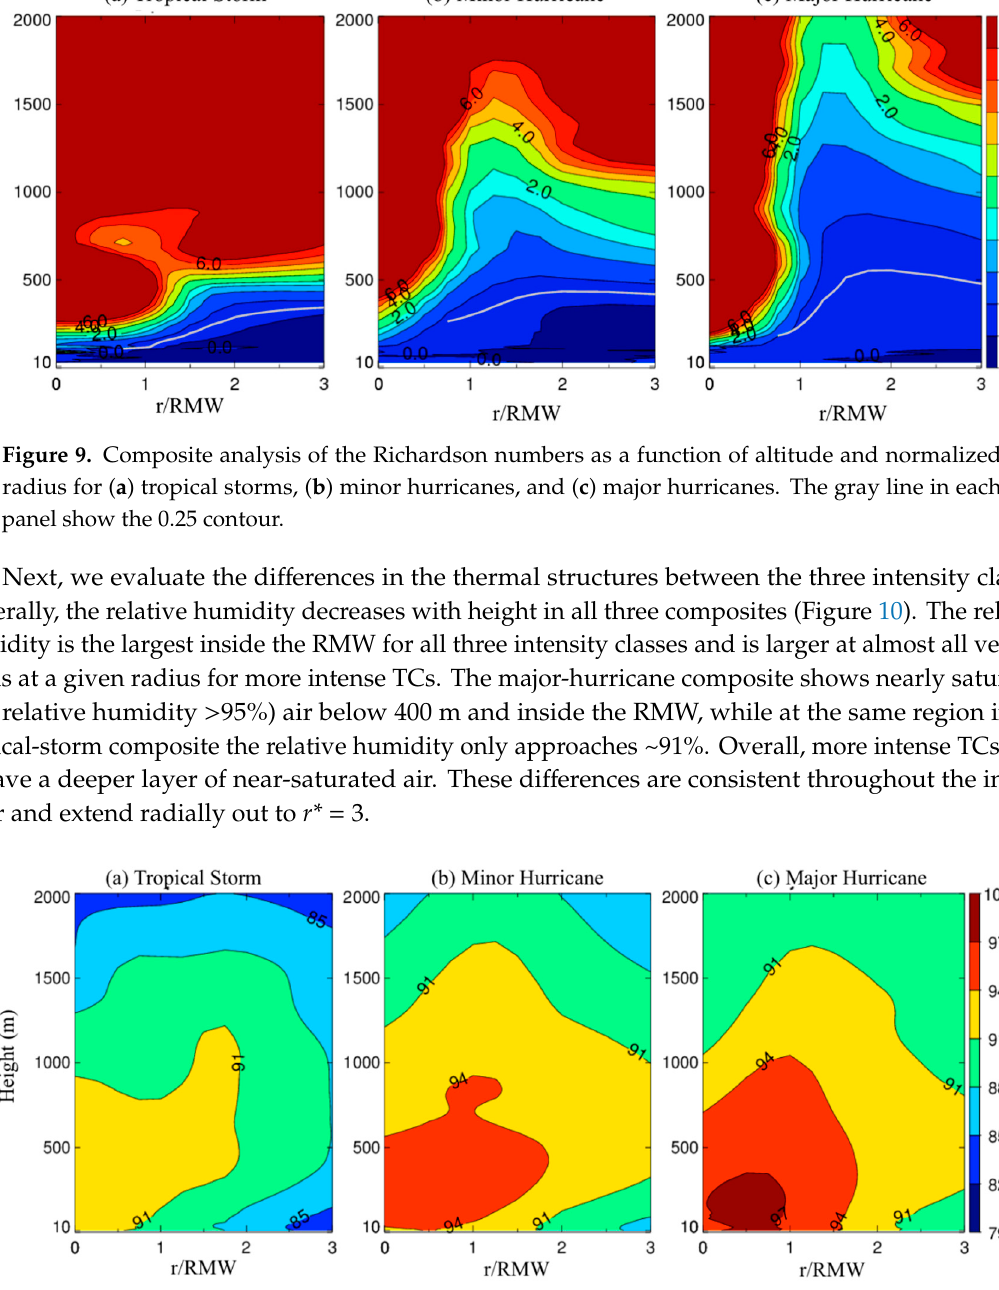
Figure 10. Composite analysis of relative humidity (%) as a function of altitude and normalized radius for ( a ) tropical storms, ( b ) minor hurricanes, and ( c ) major hurricanes. The contour interval is 3% in all panels.